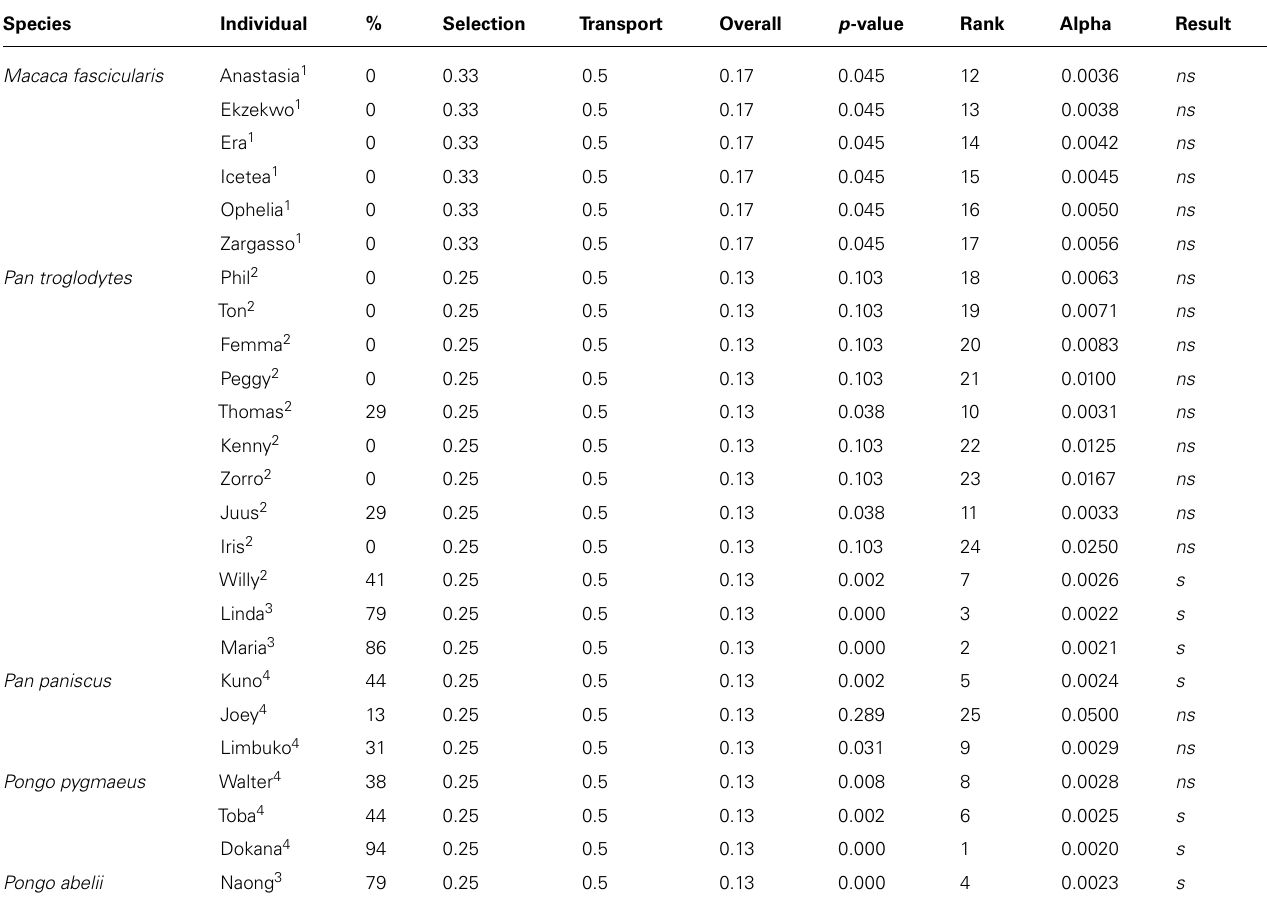
Table 2 |The overall performance of several primate species compared to chance. Species Individual % Selection Transport